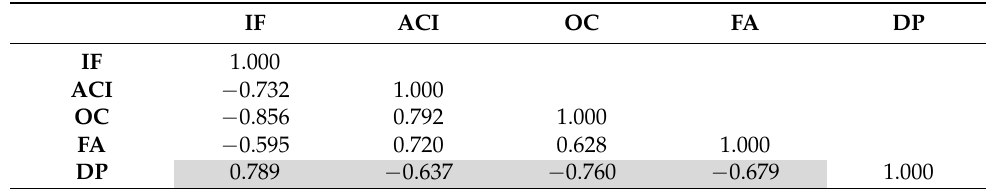
Table 4. Correlation between interfacial tension (IF), acidity (ACI), oil color (OC), 2-furfuraldhyde (FA), and degree of polymerization (DP).